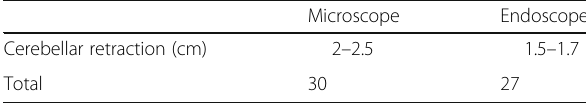
Table 4 Difference between the range of distance of cerebellar retraction through microscope and endoscope in all All patients (25)